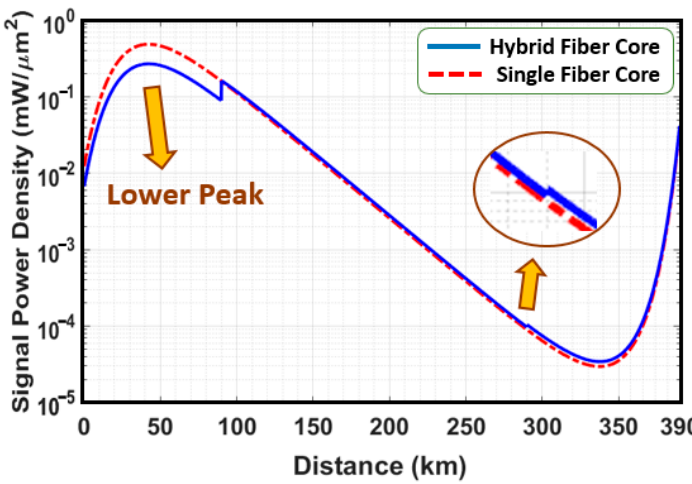
Figure 4. Signal power density of the three-segment hybrid fiber core structure compared to the conventional single fiber core structure. The hybrid fiber core structure has a lower signal power density on the first segment and a higher power density on the third segment, which indicates two advantages for the system performance.